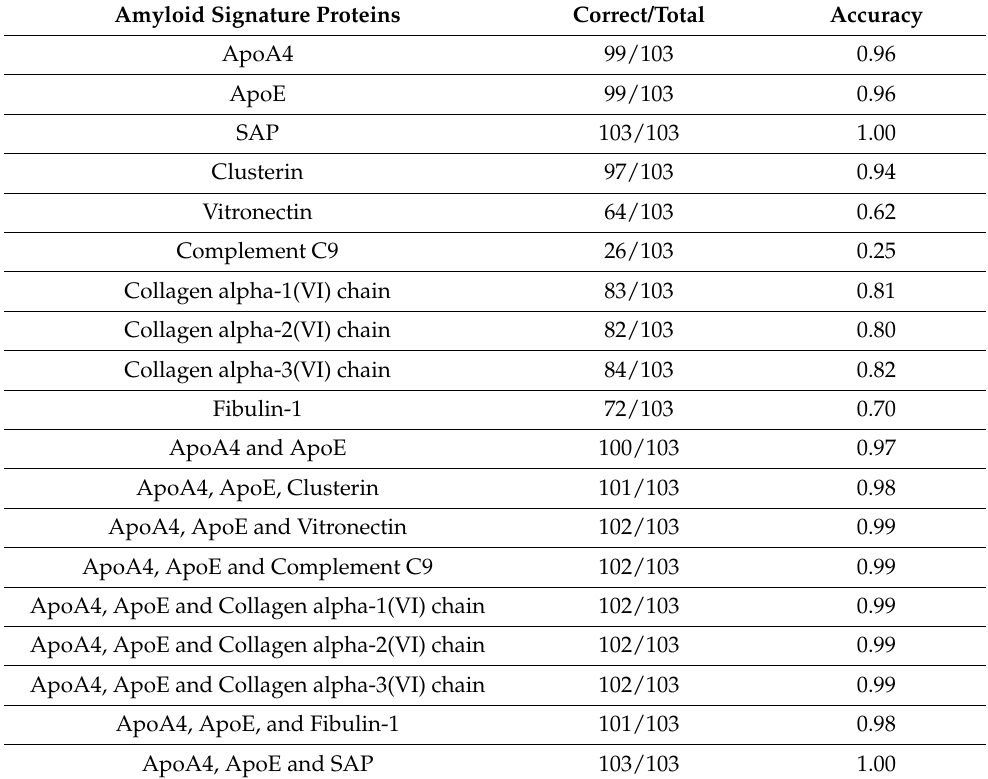
Table 3. Validation of the SVM-based models for recognizing tissue samples with amyloid deposits by testing on blinded validation data set consisting of 103 amyloid-containing tissue samples of different organ origin collected from amyloidosis patients.